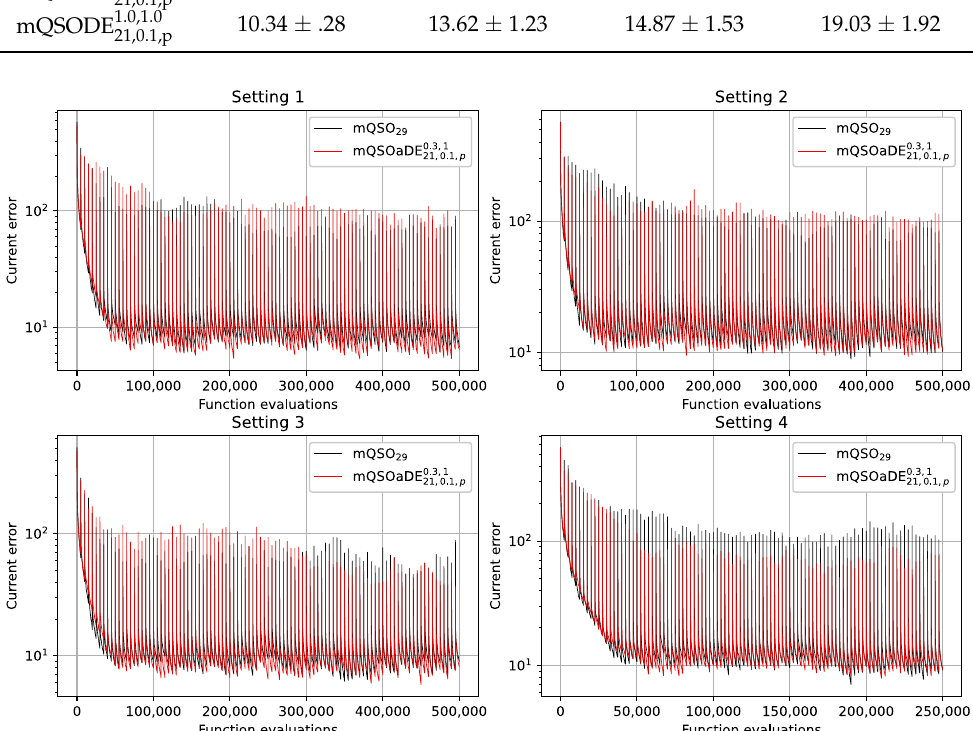
Figure 2. Current error graphs of mQSO 29 and mQSODE 21,0.1,p in four benchmark